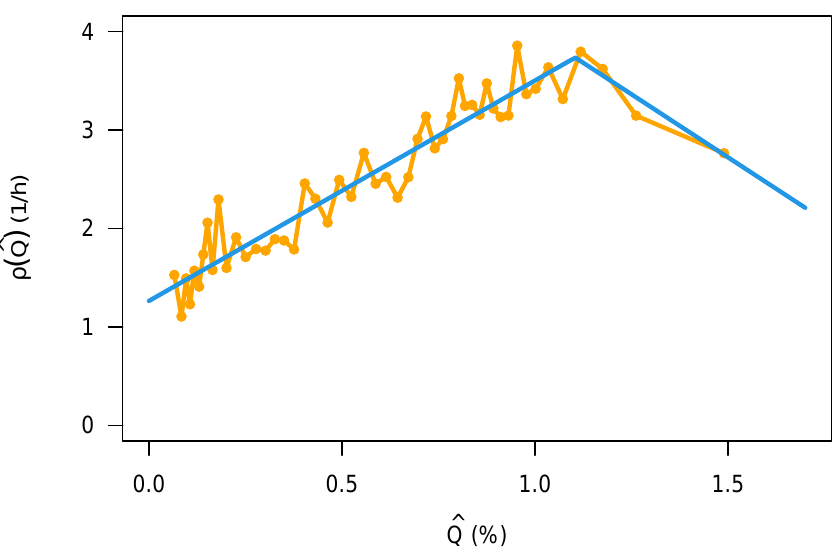
Figure 12. ρ versus ˆ Q for the severe crashes only, again with the mean values of the empirical data (orange) and the bi-linear model (blue) of Equation (9).